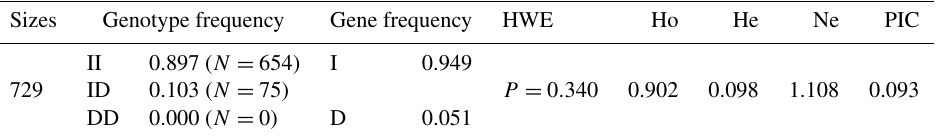
Table 2. Allelic and genotypic frequencies and genetic diversity of the 20-bp indel of CDC25A gene. Sizes